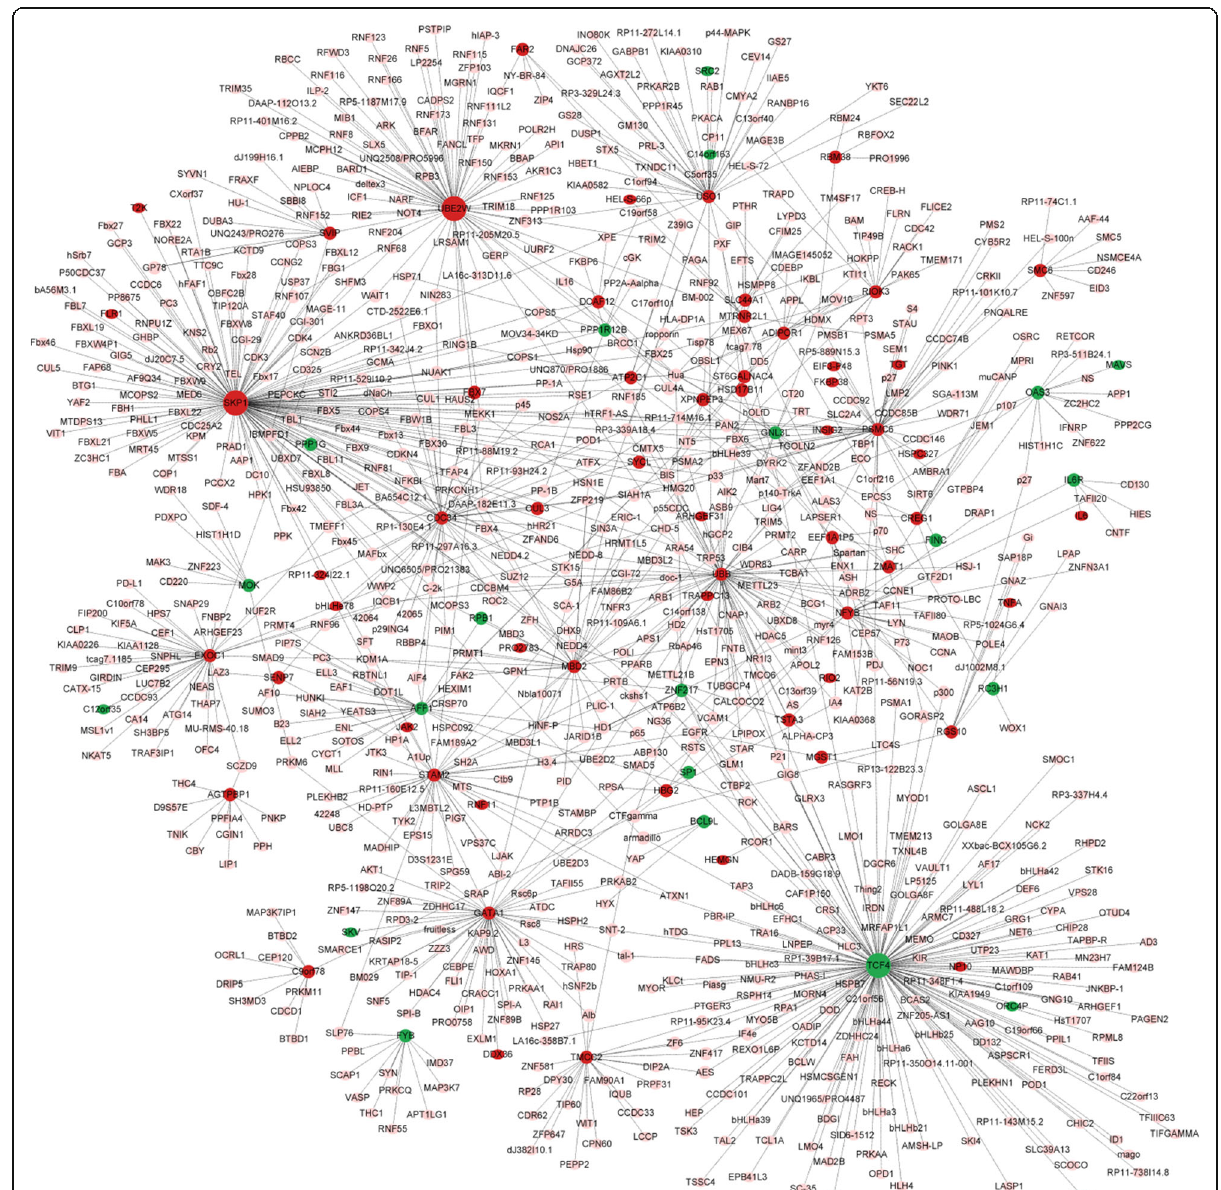
Fig. 1 The T2D-specific PPI networks of 64 dysregulated genes. Red nodes indicate up-regulated genes in T2D, blue nodes indicate down-regulated genes in T2D. Pink nodes indicate genes interacting with the differentially expressed genes, and larger icons indicate hub